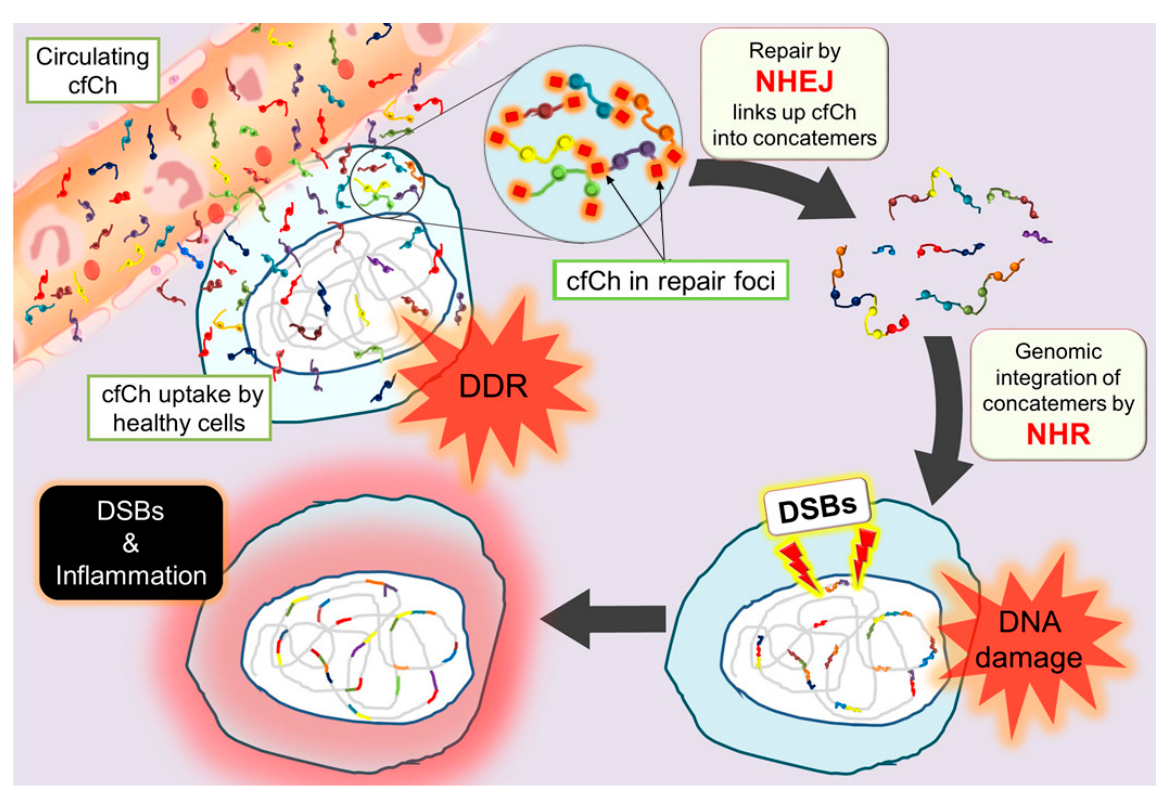
Figure 1. Schematic representation of the unique mechanism by which cell-free chromatin (cfCh) particles integrate into the genome to inflict double-strand breaks (DSBs) and to activate an inflammatory response. NHEJ: nonhomologous end-joining; NHR: nonhomologous recombination. It is to be noted that in this model damage repair response (DDR) precedes DNA damage.